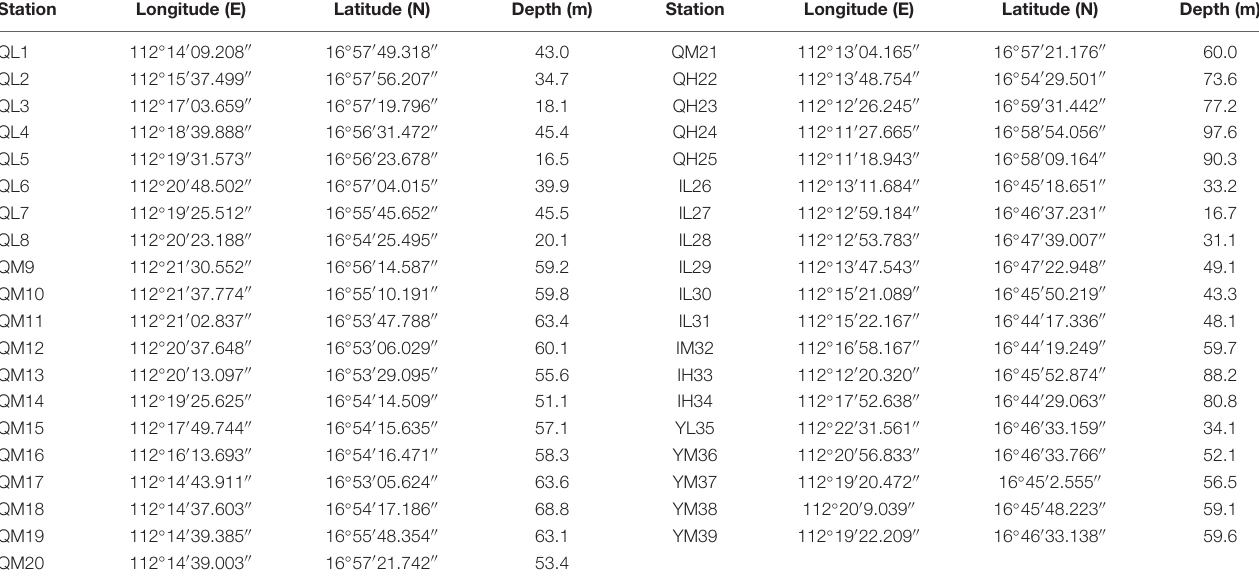
TABLE 1 | Sampling locations and depths.